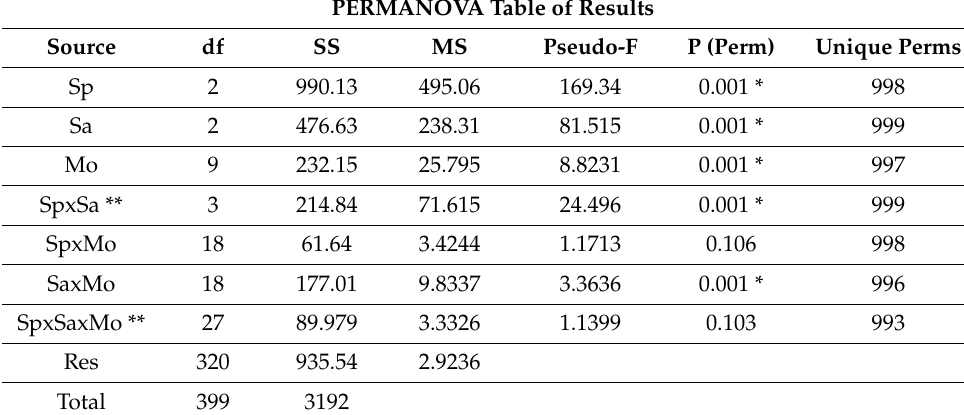
Table 3. Permutational multivariate analysis of variance (PERMANOVA) of monthly (Mo) changes in physicochemical and hydrodynamic variables under patches belonging to the most dominant observed species (Sp) at the different studied salt marshes